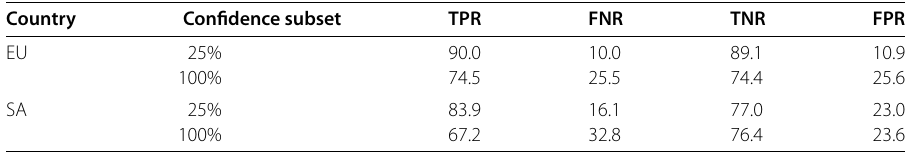
Table 2 Performance measures for SVM-RBF at different confidence thresholds in EU and SA ( Positive = Women , Negative = Men ): True Positive Rate (TPR), False Negative Rate (FNR), True Negative Rate (TNR), False Positive Rate (FPR) Country Confidence subset TPR FNR TNR FPR EU 25% 90.0 10.0 89.1 10.9 100% 74.5 25.5 74.4 25.6 SA 25% 83.9 16.1 77.0 23.0 100% 67.2 32.8 76.4